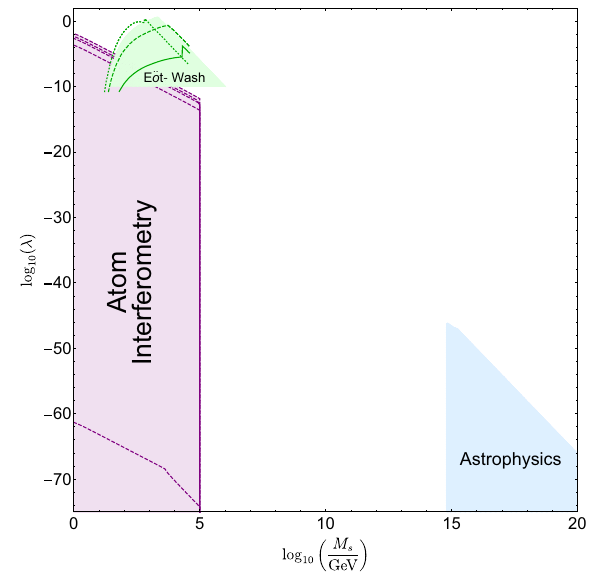
Fig. 10 The current bounds on the symmetron parameters M s and λ . The region of parameter space excluded by each specific test is indicated in the figure. The Eöt-Wash region corresponds to μ = 2 . 4meV; the outlines for values μ = { 10 − 4 , 10 − 3 , 10 − 2 } eV are shown by the solid, dashed, and dotted green lines respectively. The atom interferometry lines correspond to the regions excluded for μ = { 10 − 4 , 10 − 4 . 5 , 10 − 5 , 10 − 5 , 2 . 4 × 10 − 3 } eV from top to bottom respectively, the latter value corre- sponding to the dark energy scale. The astrophysical bounds are insensitive to the value of μ for the values considered here